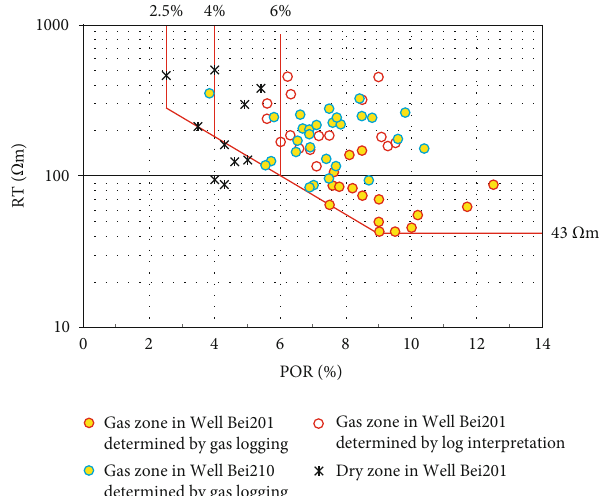
Figure 10: Scatter plot of results from gas logging and log interpretation of tight sandstone